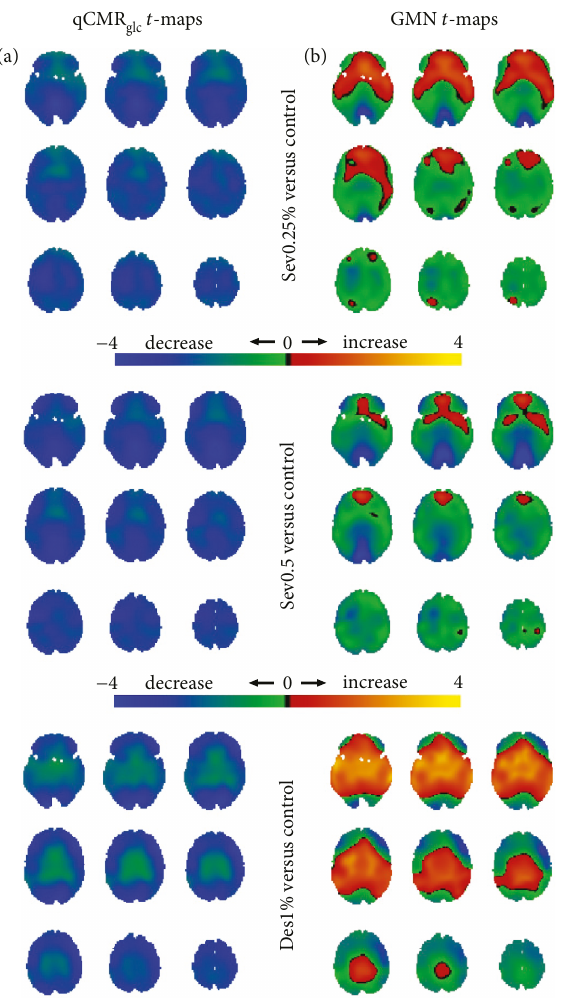
Figure 4: Spatial distributions of metabolic variations with sedation (i.e., Des1%, Sev0.25%, and Sev0.5% in Figure 2(b)) versus the control group (i.e., HAEC in Figure 2(a)), shown with respect to unthresholded Student ’ s t -maps using (a) qCMR images and (b) GMN images. glc (a) For Des1%, Sev0.25%, and Sev0.5% groups, the unthresholded t -maps with qCMR indicated globally unidirectional metabolic glc decreases with sedation. (b) However, the unthresholded t -maps with GMN depicted regions with metabolic increases and decreases upon sedation. Based on validation of qCMR to aCMR -HYD (Figures 1 and 2; Table 2), without GMN the global decreases corresponded to glc glc about 0.05 μ mol/g/min (Des1% ≈ Sev0.5% < Sev1%) and with GMN the deemphasis on global changes put the focus on the regional di ff erences. See Figure S4 for thresholded maps (Table